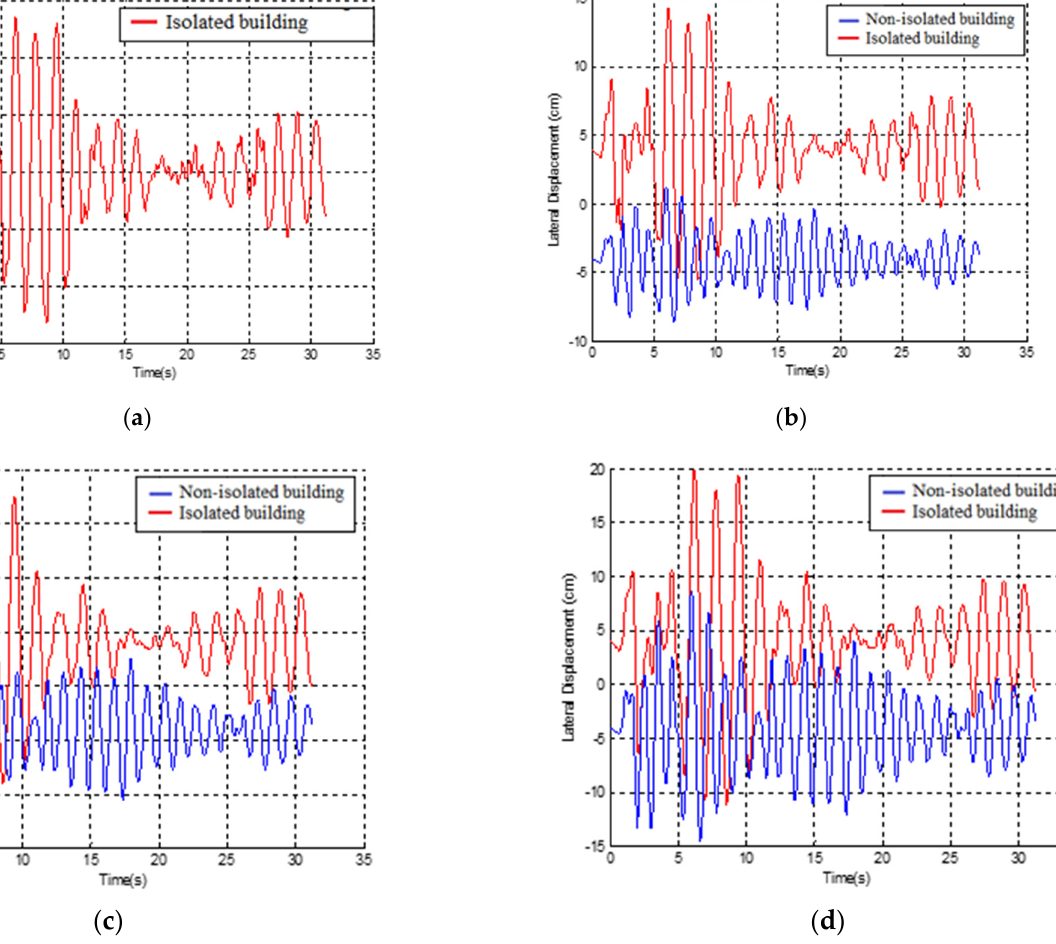
Figure 7. Lateral displacement time histories of non-isolated and the isolated buildings with an 8 cm size gap: ( a ) base level; ( b ) first story; ( c ) second story; ( d ) third story. The maximum impact forces in each story were calculated to be 2.38 × 10 5 kN, 6.9 ×